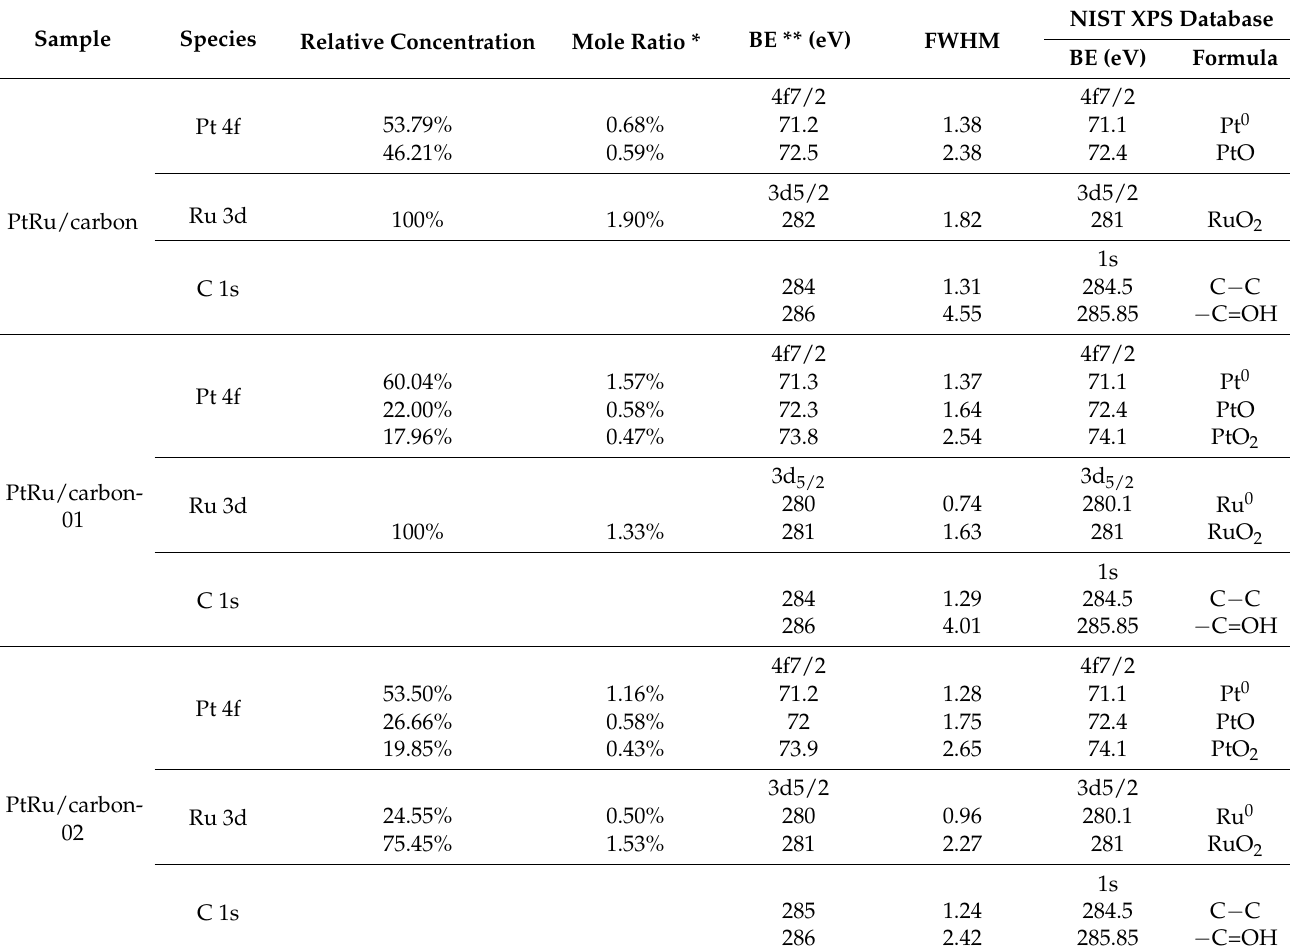
Table 5. Surface compositions of the